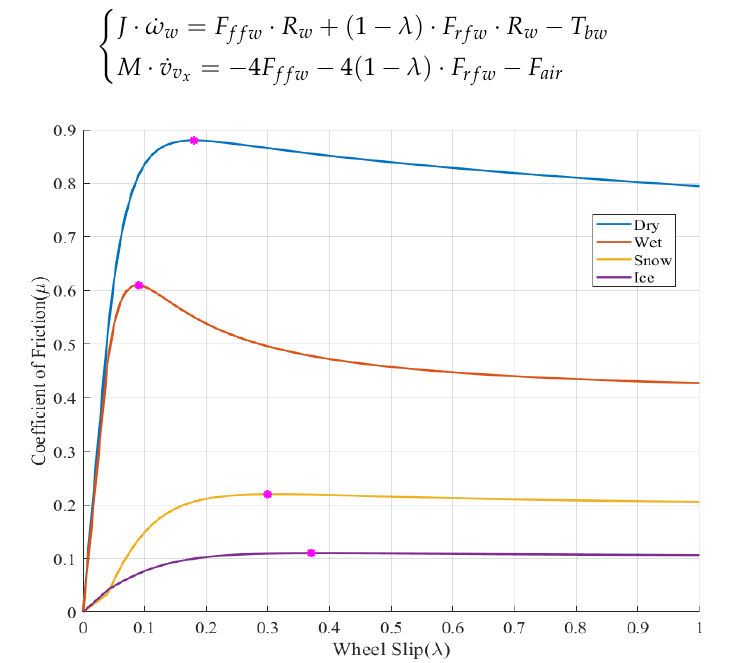
Figure 1. The relationship between λ and µ . Table 1. Several key points of µ ( λ )